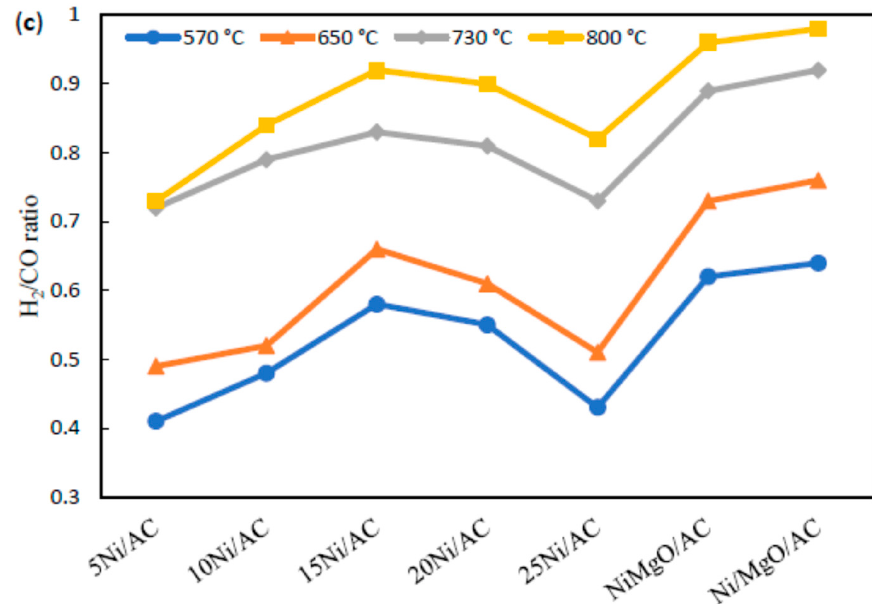
Figure 3. ( a ) CO ₂ and ( b ) CH ₄ conversions and ( c ) product selectivity as a function of temperature over the prepared catalysts using microwave heating.